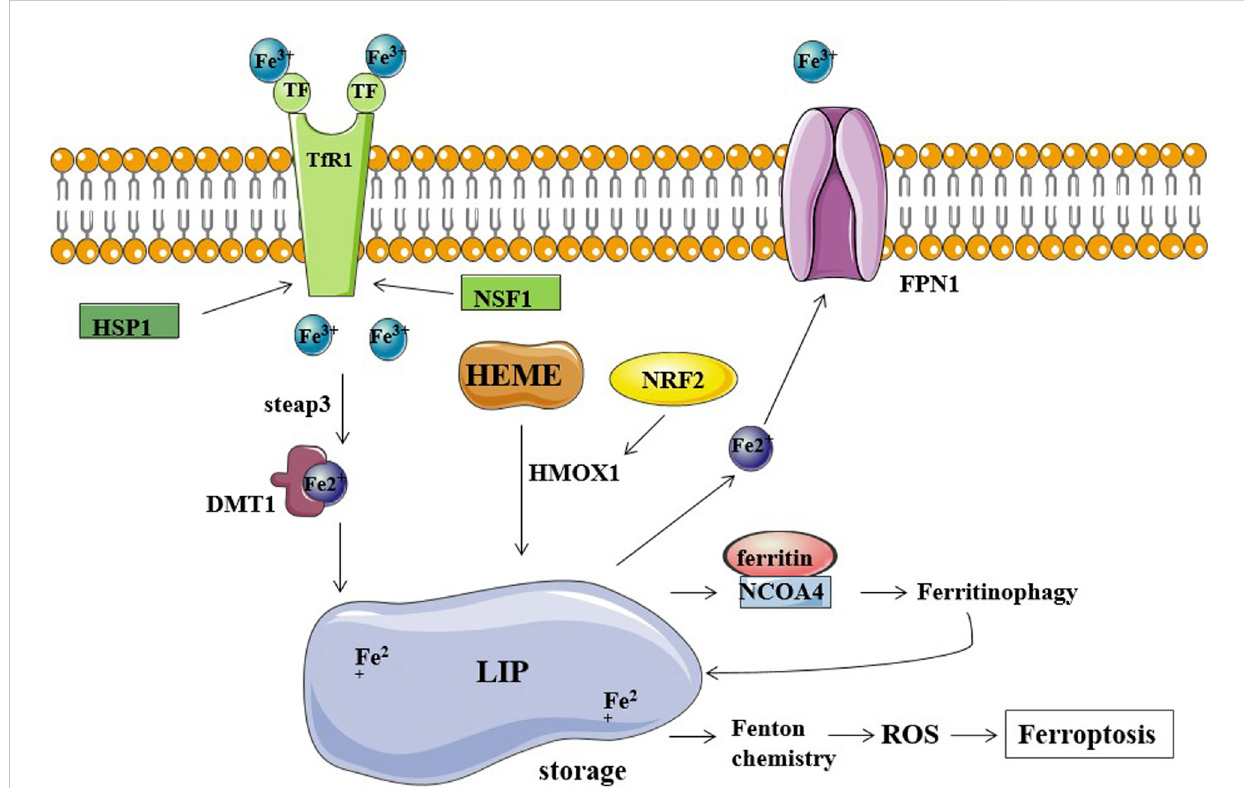
Iron metabolism and ferroptosis. Fe 2+ storage in LIP (labile iron pool) participates in the Fenton reaction producing ROS and causing ferroptosis. TfR1, TF, and FPN1 are the major regulators of cellular iron balance on the cell membrane. TF transports Fe 3+ into cells by TfR1-mediated endocytosis. HSP1 inhibits this process by inhibiting TfR1, while NSF1 can increase TfR1 levels. Fe 3+ is converted to Fe 2+ by STEAP3 and released into the cytoplasm via DMT1. FPN1 exports and decreases intracellular iron levels. Ferritin stores iron and limits the iron-catalyzed Fenton reaction. NCOA4 binds ferritin mediating its autophagic degradation in a process called